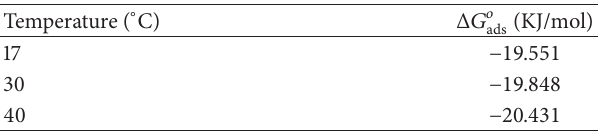
Table 5: Gibbs free energy of mild steel corrosion in 1MHCl with